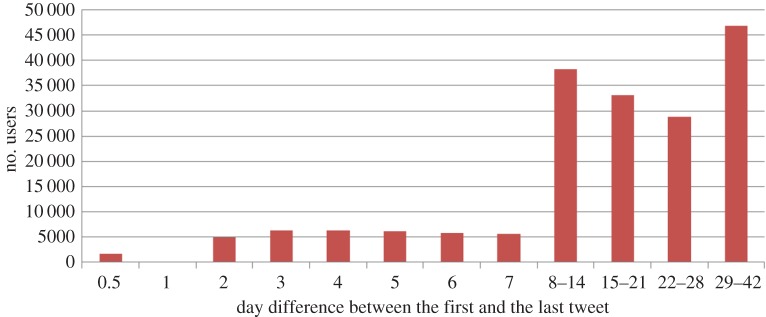
Histogram of the number of days between the first tweet and the last tweet in our snowball-sampled data, for those users who had posted at least 200 tweets since account creation.